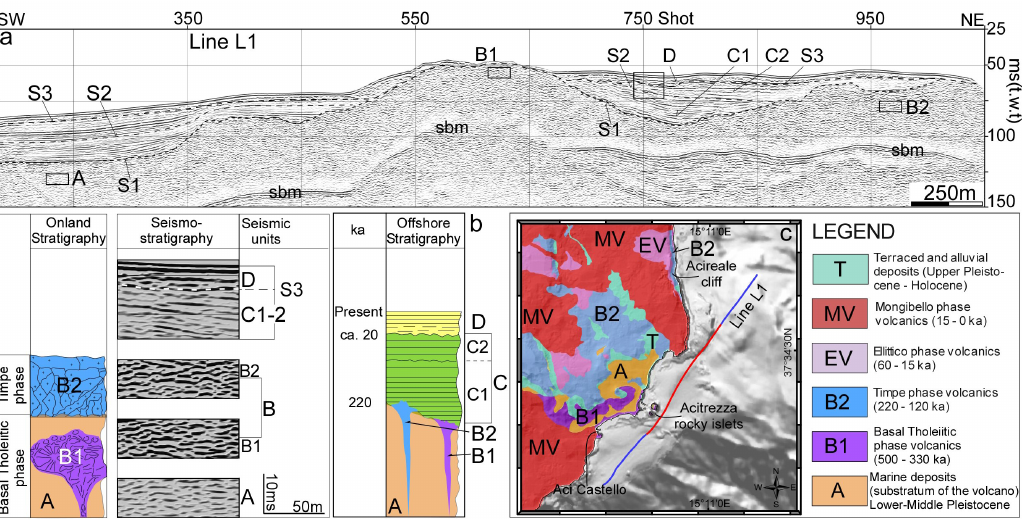
Figure 2. ( a ) Geometry and distribution of detected seismic units along a portion of line L1 (red haloed portion in Figure 2c); ( b ) A seismo-stratigraphic model reconstructed from seismic facies analysis; and ( c ) correlation of the seismic units with age-constrained volcanics and sedimentary deposits outcropping on-land (age of volcanics from [2]). S1, S2 and S3 are erosional surfaces (see text